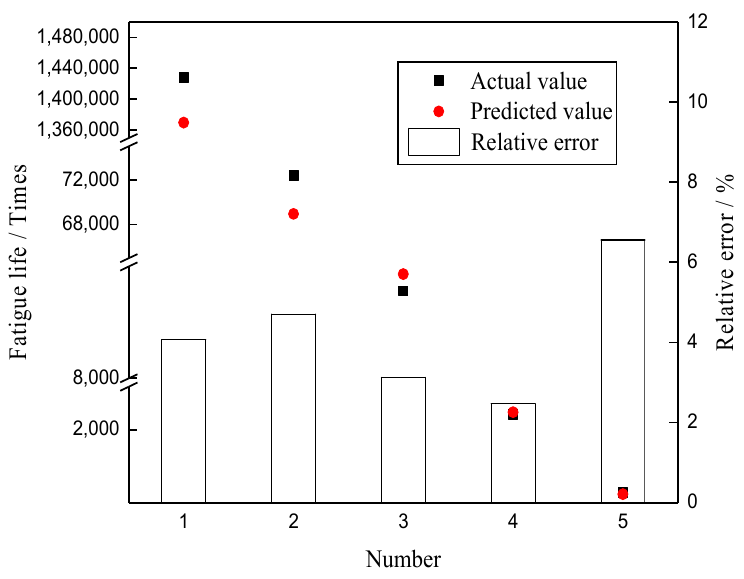
Figure 11. Validation results of fatigue life prediction model.